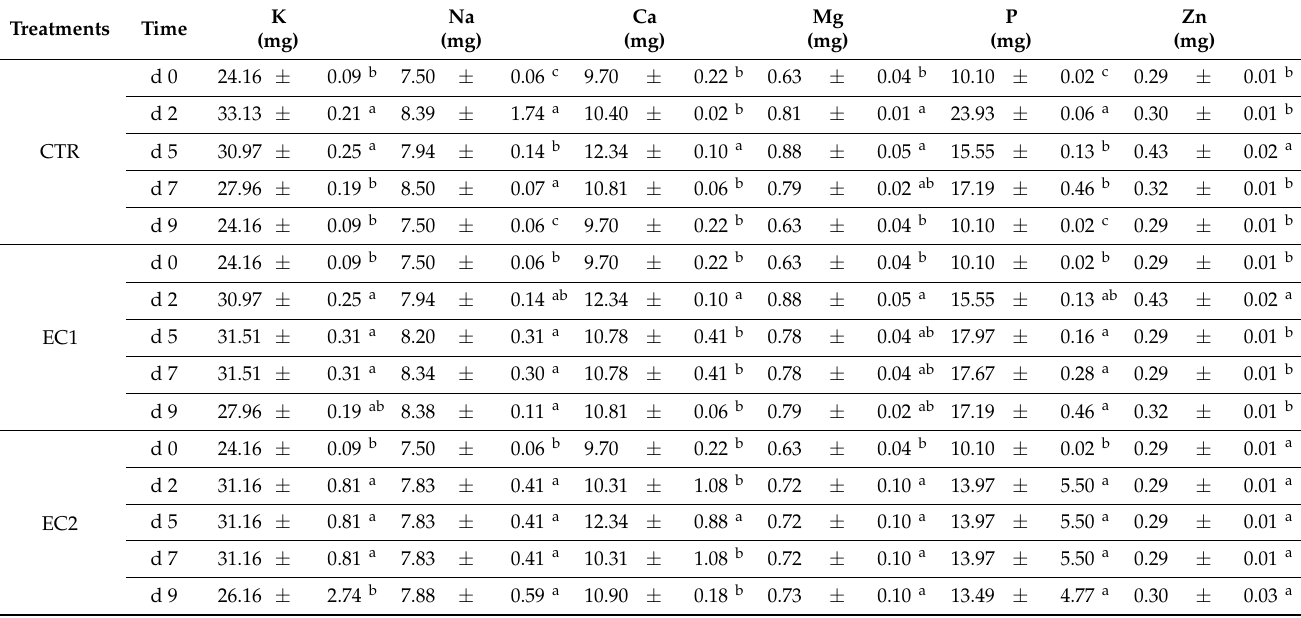
Table 3. Milligrams of mineral compounds in mango cube